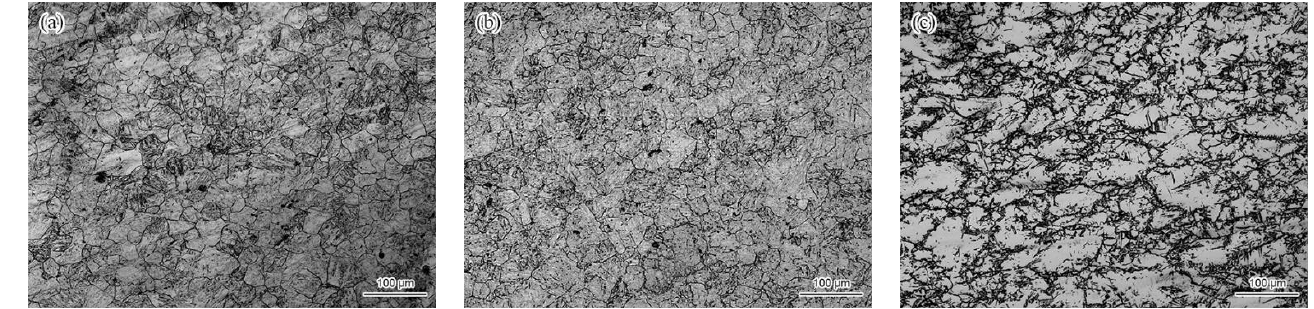
Figure 3. Austenite grain morphology with different steels of ( a ) Nb-1, ( b ) Nb-2 and ( c ) Nb-3. Based on the YB/T 5128-93 standard, the CCT curves of Nb-microalloyed steel were drawn at three different thermal simulation experiment process in this paper. This paper used a combination of the expansion method, metallographic method and hardness method to draw the CCT curves. According to the position of the inflection point on the expansion curve and the result of microstructure inspection, the type of each transformation can be determined. Then, the tangent method was used to determine the critical point of each used to plot the test results to get the CCT curve under this condition. The tested steel was heated at 0.05 ◦ C/s to 950 ◦ C by Formastor-F II automatic phase change measuring device (Fuji Radio Machinery Co., Ltd, Fuji, Japan). A c1 and A c3 temperatures were